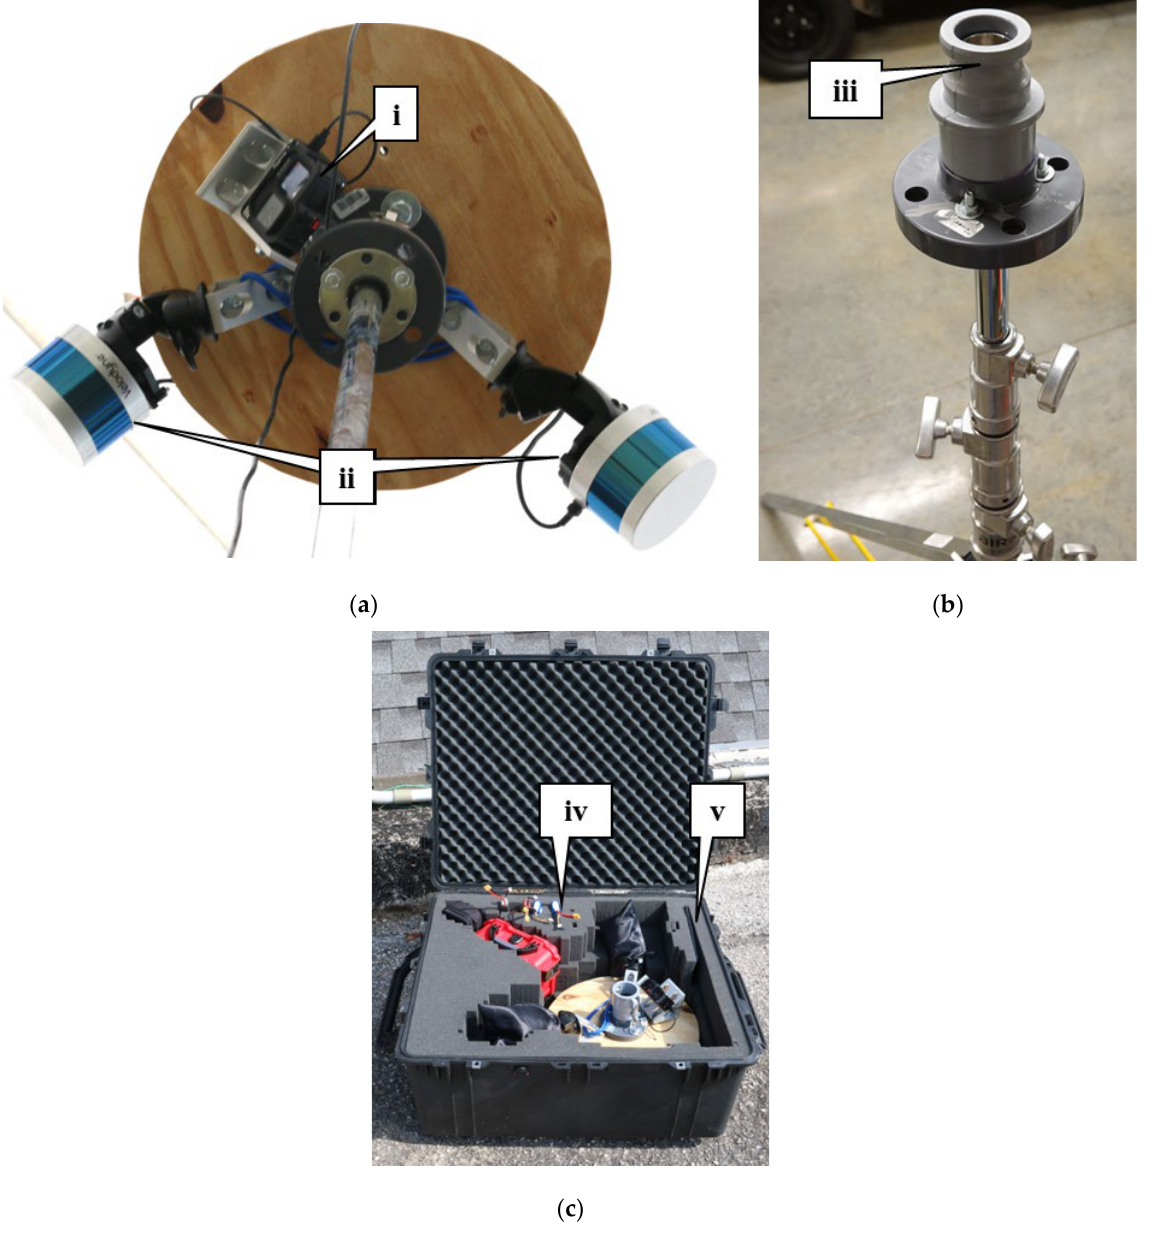
Figure 3. The SMART system for data acquisition ( a ) SMART System ( b ) SMART Portable Tripod ( c ) SMART System Packaging for Portability.